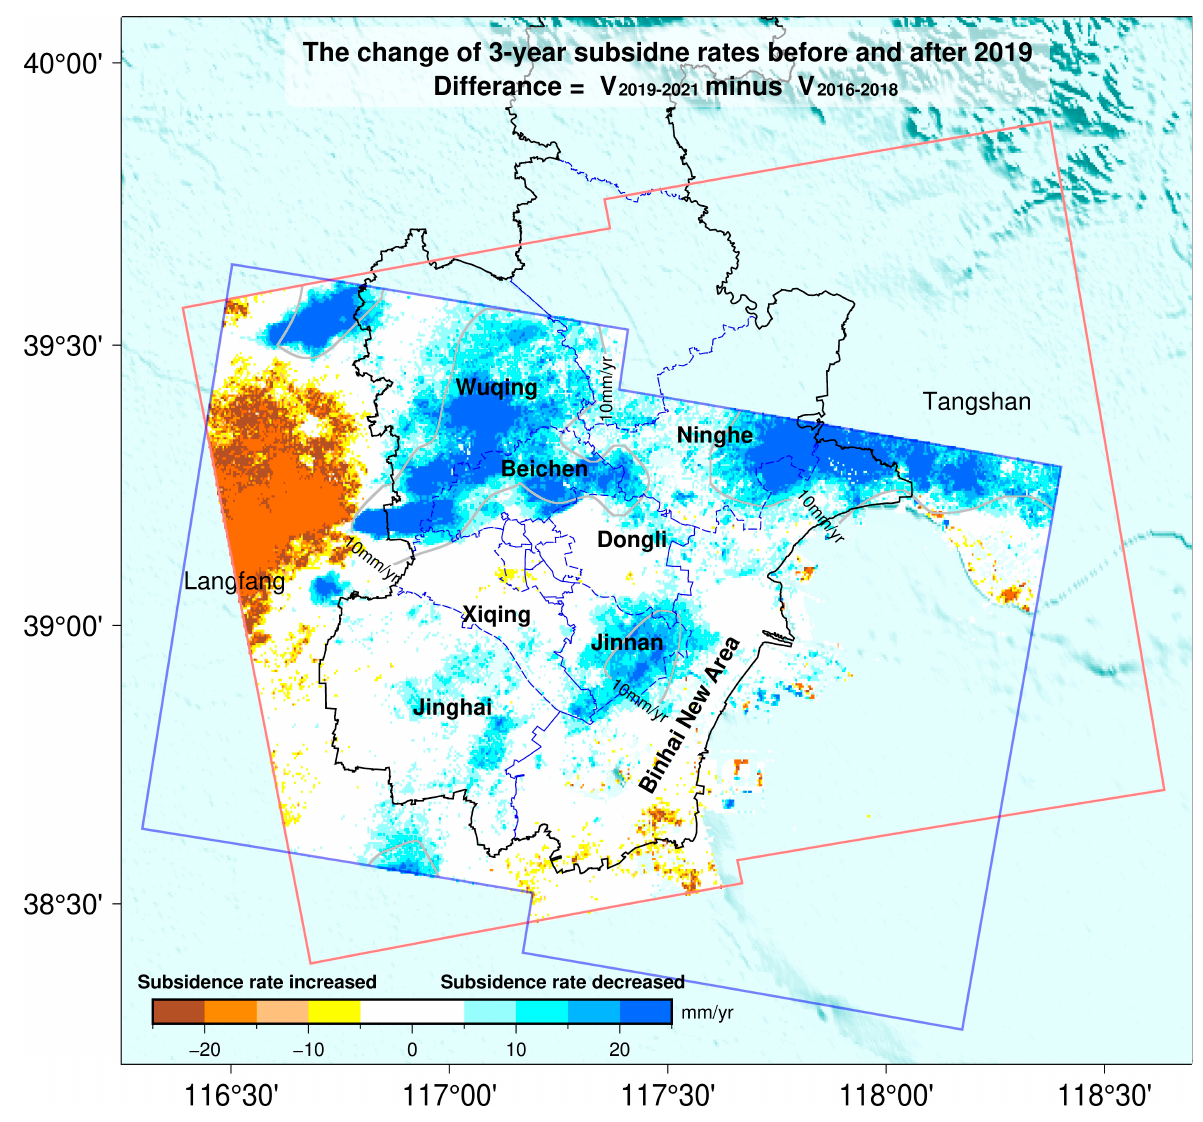
Figure 11. The change of InSAR-derived 3-year subsidence rates before and after the beginning of 2019. The area that subsidence rate has reduced over 10 mm/year is about 2900 km 2 , about 30% of the overlapped study area in Tianjin (~10,100 km 2 ).